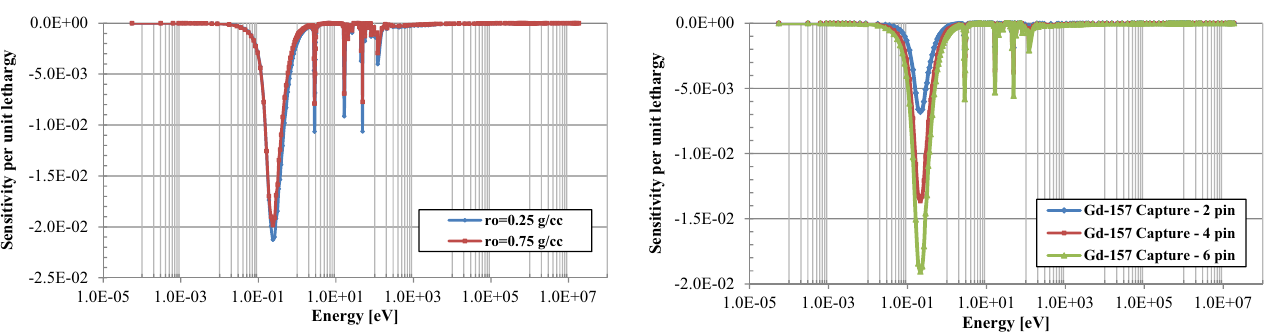
Fig. 6. Effect of number of gadolinium fuel pins on the sensitivity pro fi le.